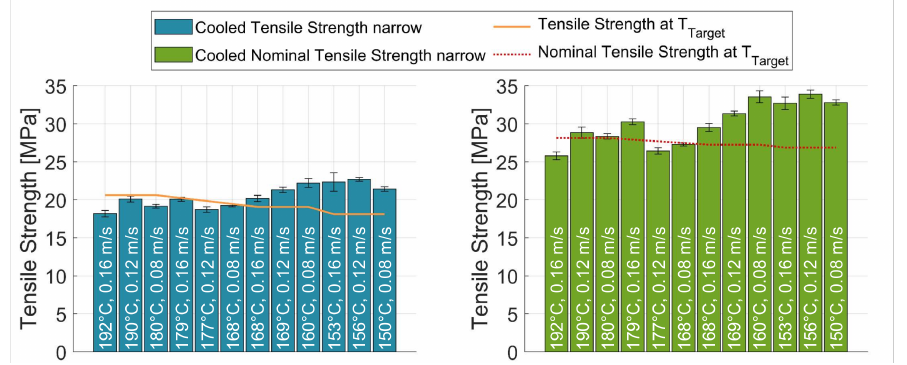
Figure 11. Standard and nominal transverse tensile strength of the cooled specimens at 50 mm cooling distance with the reference tensile strengths for unheated specimens at the achieved heated temperatures.